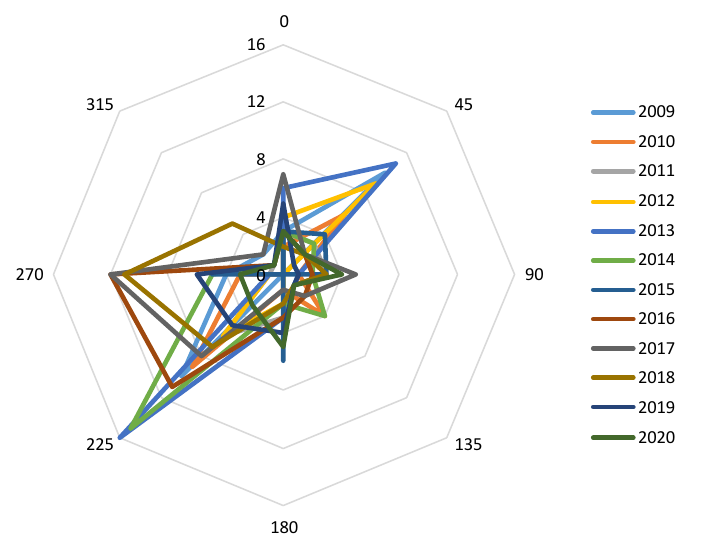
Figure 2. Wind rose of Ourense, number of days along the main pollen season in each study year in that wind blows in each direction.